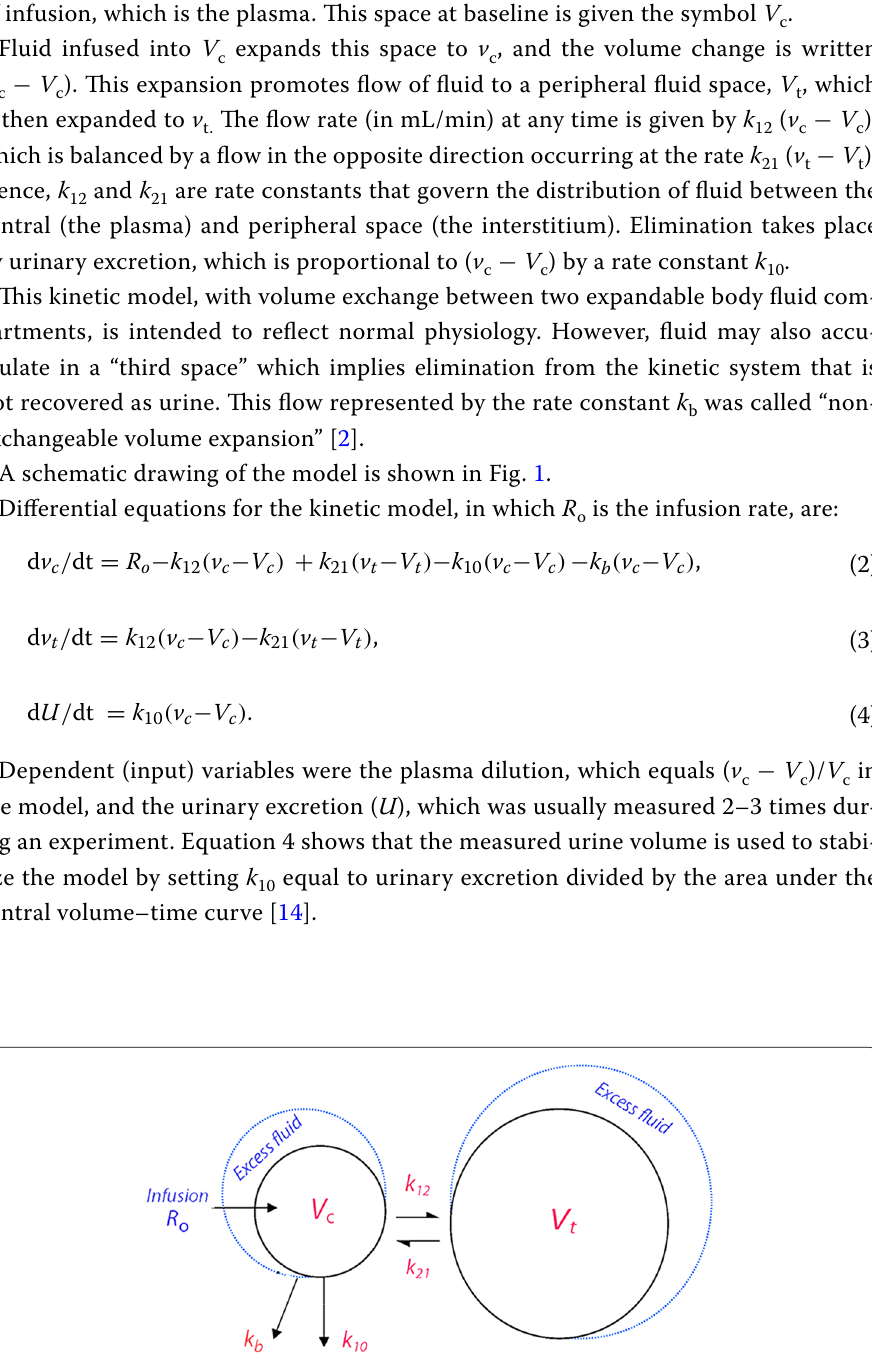
Fig. 1 Kinetic model. Schematic drawing of the kinetic model used to analyze the distribution and elimination of Ringer’s